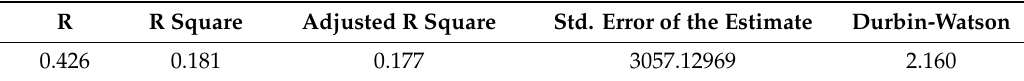
Table 3. Summary of the regression